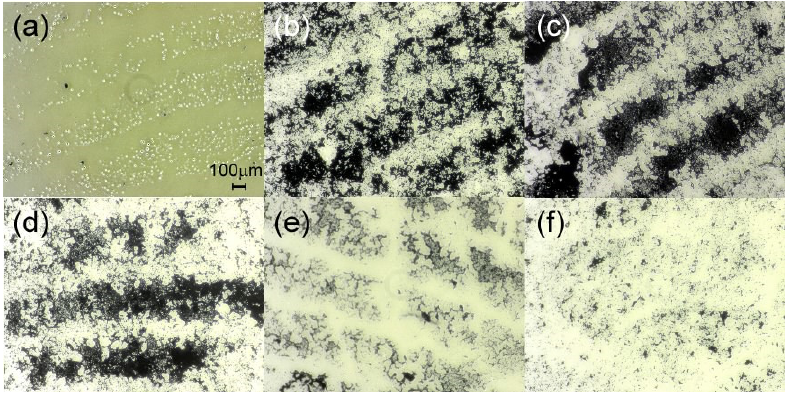
Figure 6. Optical micrographs of ( a ) unprocessed fingerprint, ( b ) fingerprint with activated carbon powder, and ( c ) fingerprint with CHCA/HM20. Images of fingerprint after laser irradiation for ( d ) 30 s, ( e ) 1 min, and ( f ) 5 min.